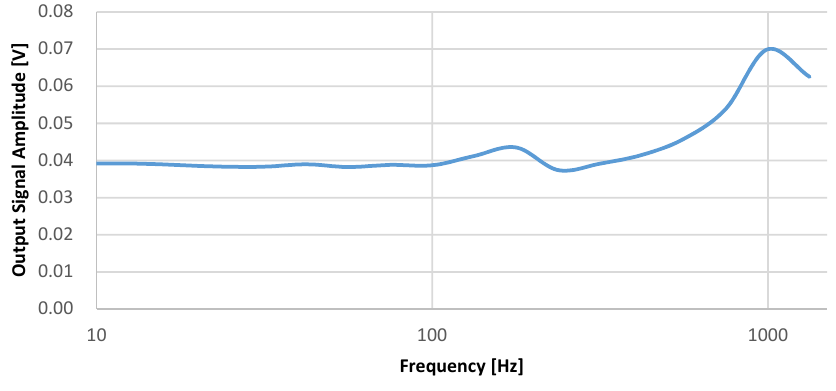
Figure 14. The frequency response of the system.